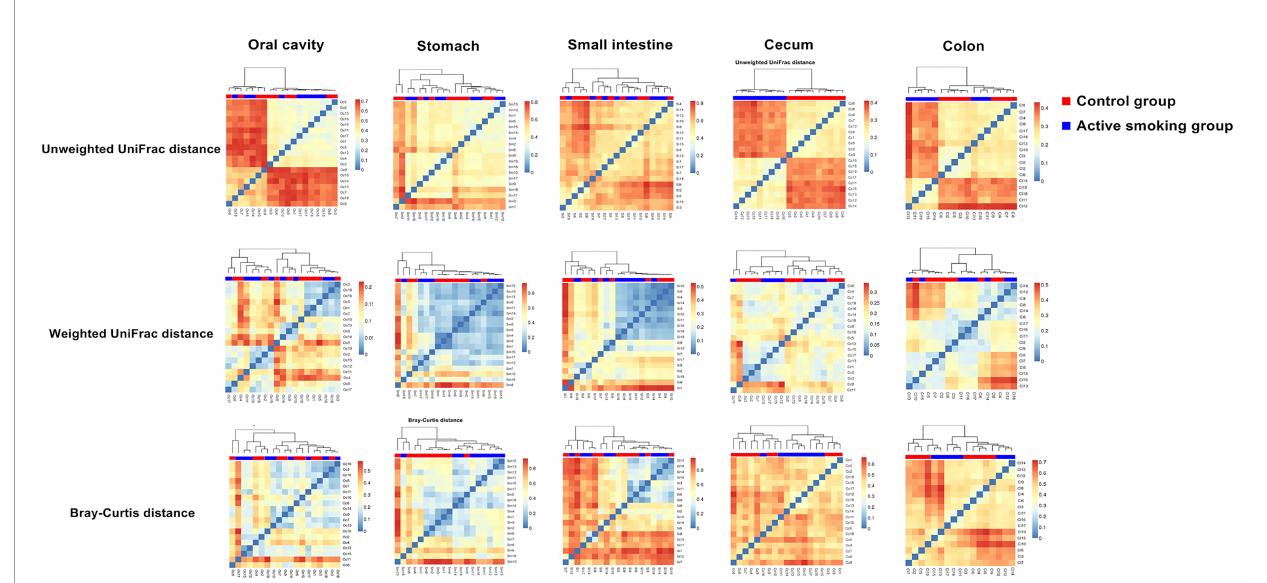
FIGURE 5 | Matrix heatmaps based on beta analysis metrics separately show the community structure dissimilarity in the oral cavity, stomach, small intestine, cecum, and colon according to active smoking